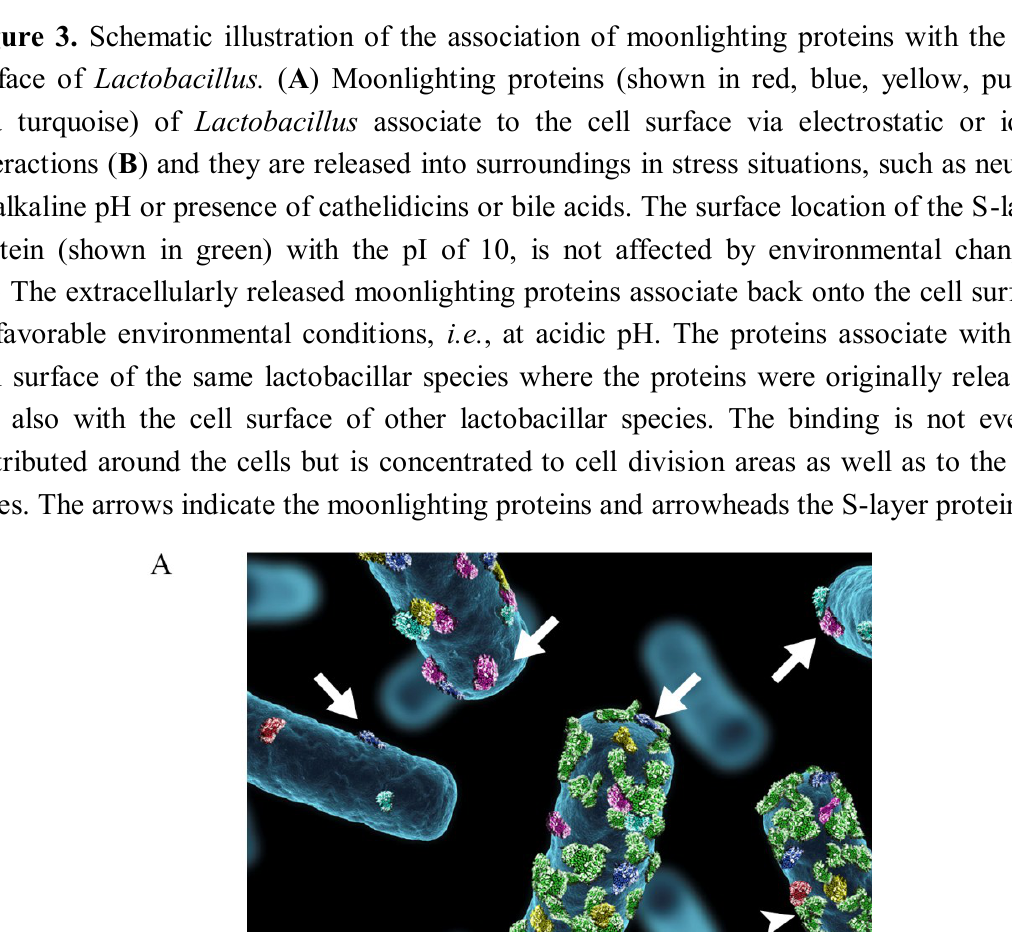
Figure 3. Schematic illustration of the association of moonlighting proteins with the cell surface of Lactobacillus. ( A ) Moonlighting proteins (shown in red, blue, yellow, purple and turquoise) of Lactobacillus associate to the cell surface via electrostatic or ionic interactions ( B ) and they are released into surroundings in stress situations, such as neutral or alkaline pH or presence of cathelidicins or bile acids. The surface location of the S-layer protein (shown in green) with the pI of 10, is not affected by environmental